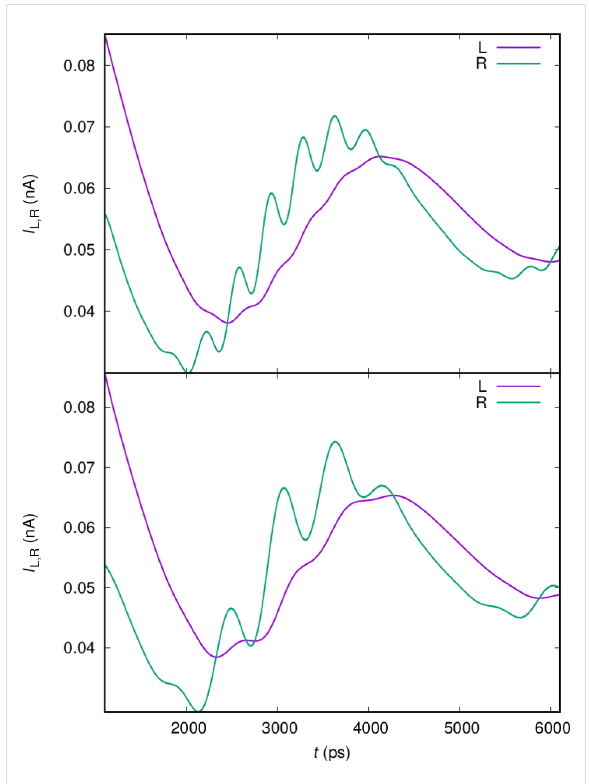
Figure 7: The current from the left lead (L) into the central system and the current from the central system into the right lead (R), for x - (upper), and y -polarized (lower) cavity photon field. g EM = 0.05 meV, = 0.343 meV, κ = 1.0 × 10 − 5 meV, = 0, and B ext = 0.05